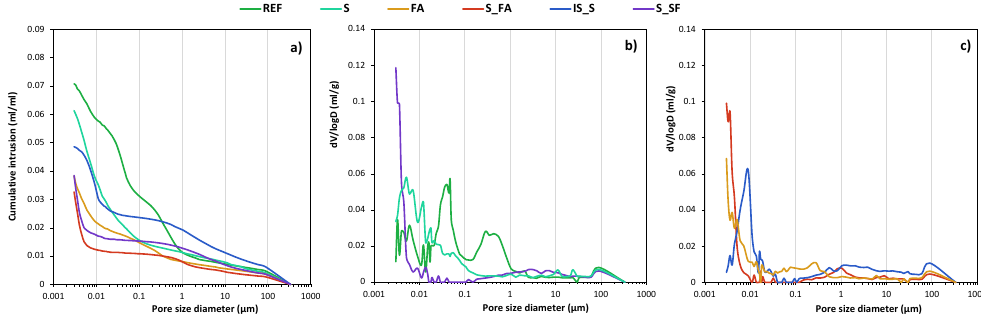
Figure 3. ( a ) Pore size distribution cumulative curve and ( b ) and ( c ) pore size distribution differential curve at 28 days.